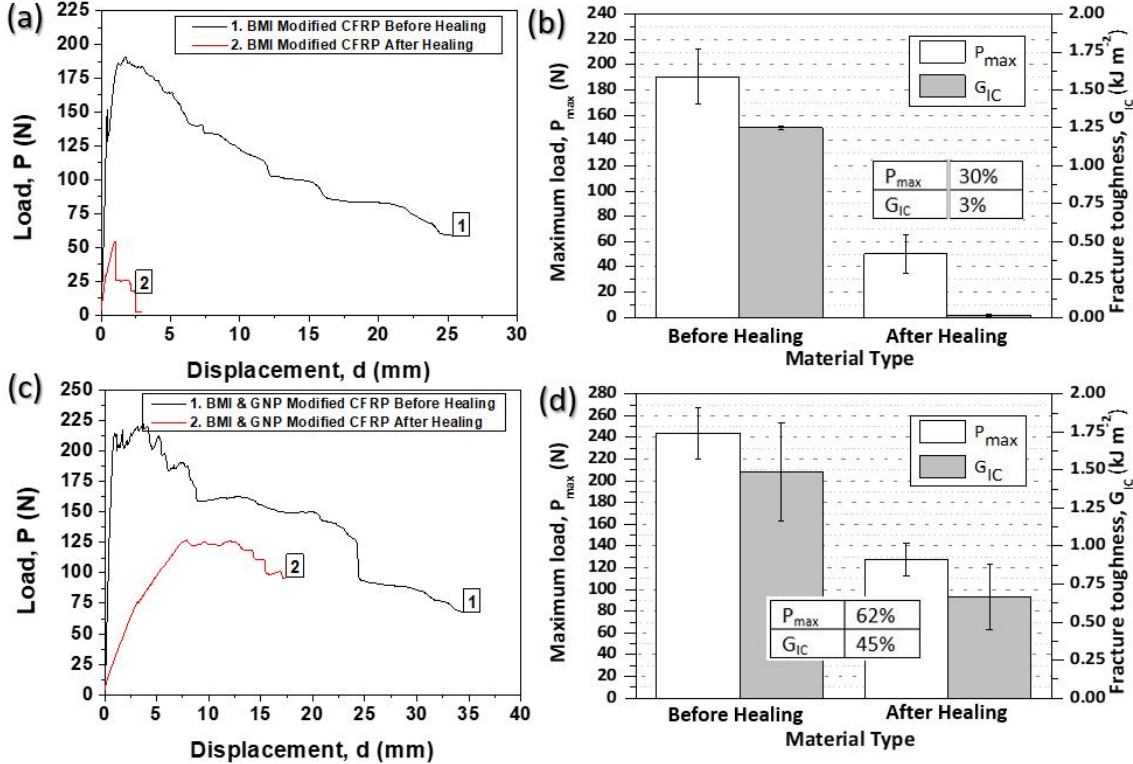
Figure 6. ( a , c ) Representative load (P) vs. displacement (d) curves for the two modified CFRPs, respectively before and after the activation of the healing process, ( b , d ) synopsis of Mode I testing results regarding the peak load (P max ) and fracture toughness energy I (G IC ) values together with healing efficiencies (H.E.) for modified CFRPs with BMI and BMI and GNPs, respectively.